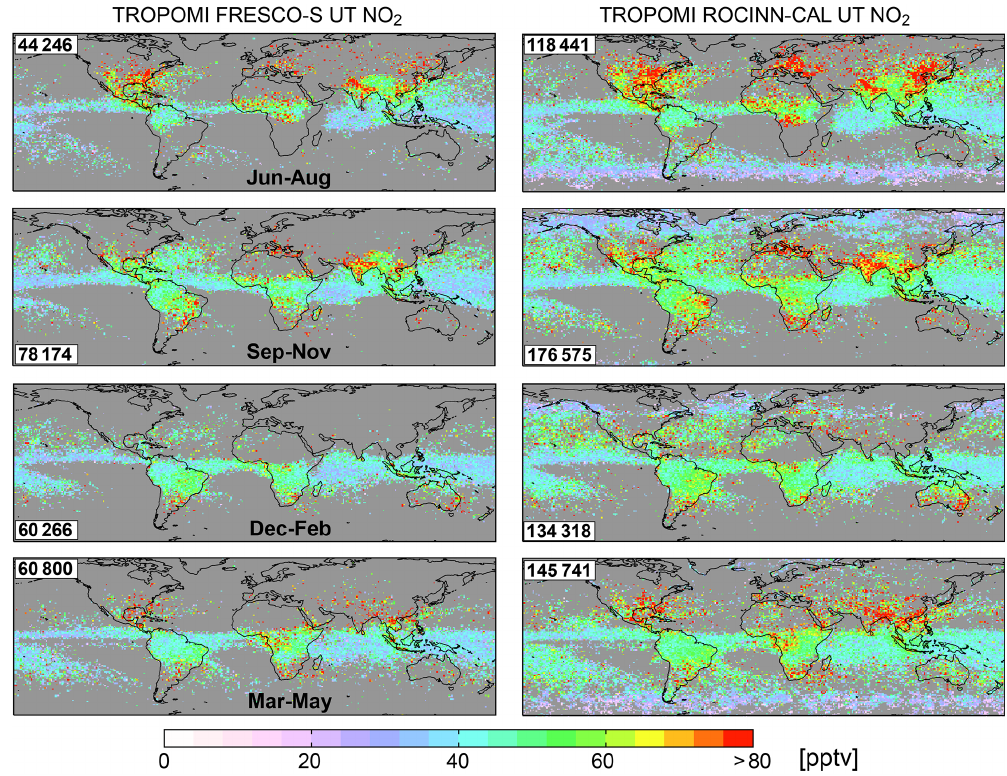
Figure 5. Seasonal mean NO 2 in the upper troposphere from TROPOMI. Maps are UT NO 2 at 1 ◦ × 1 ◦ in June–August 2019 (first row), ROCINN-CAL (right) cloud information and with corrections applied to TROPOMI stratospheric and tropospheric columns (see text for details). Inset numbers give total successful cloud-sliced retrievals. Grey grid squares have fewer than five cloud-sliced